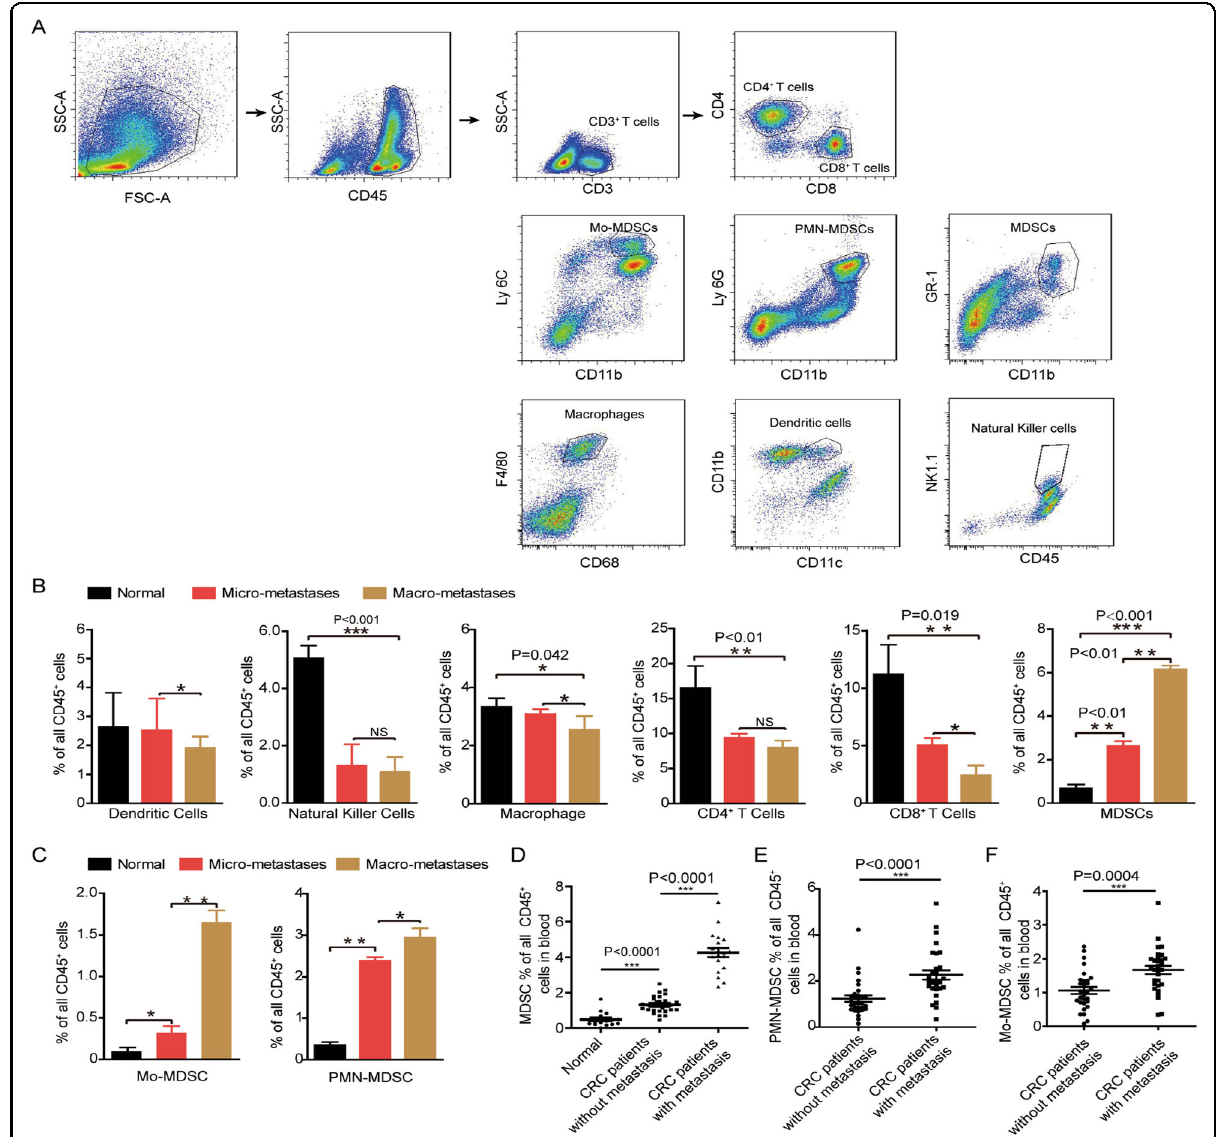
Fig. 2 MDSCs constantly accumulated in the liver during CRC process. A Diagrams of immune cells by fl ow cytometry sorting. CD45 + cells were fi rst sorted and were stained with CD3 and CD4 antibodies; CD8 + T cells were stained with CD3 and CD8 antibodies; dendritic cells were stained with CD11b and CD11c antibodies; macrophages were stained with F4/80 and CD11b antibodies; natural killer cells were stained with NK1.1 antibodies; MDSCs were stained with CD11b, Gr-1 or Ly6G or Ly6C antibodies. B Analysis of the numbers of immune cells in CRC liver metastases. C Analysis of the numbers of Mo-MDSCs or PMN-MDSCs in CRC liver metastases. ** P < 0.01, *** P < 0.001. D – F Analyses of the MDSCs percent in CRC patients ’ blood. Normal ( n = 20), CRC with metastasis ( n = 30), CRC without metastasis ( n = 30). Error bars represent mean ± SD from at least three independent experiments. ** P < 0.01, *** P <